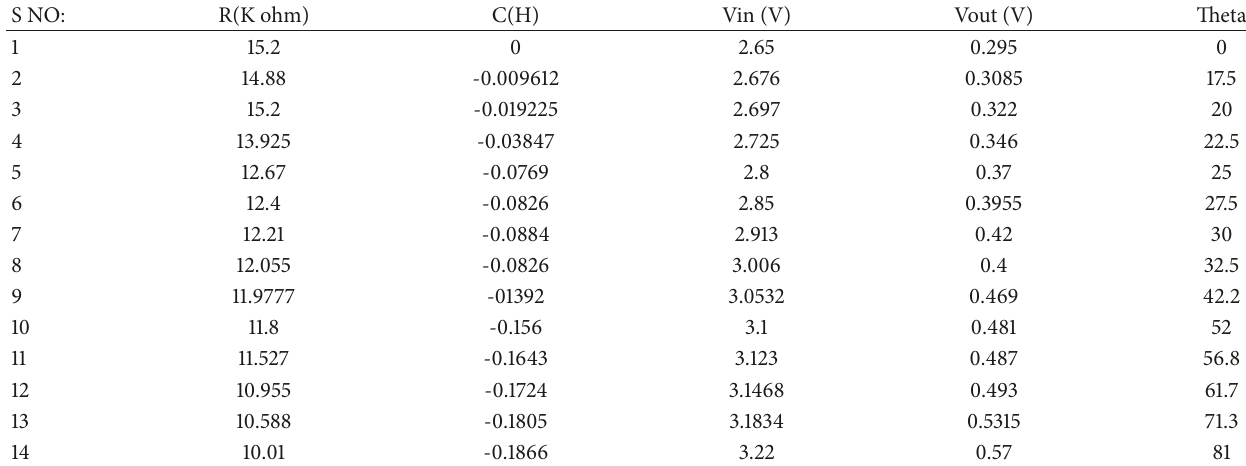
Table 1: Different voltage reading for different resistances of the Flux